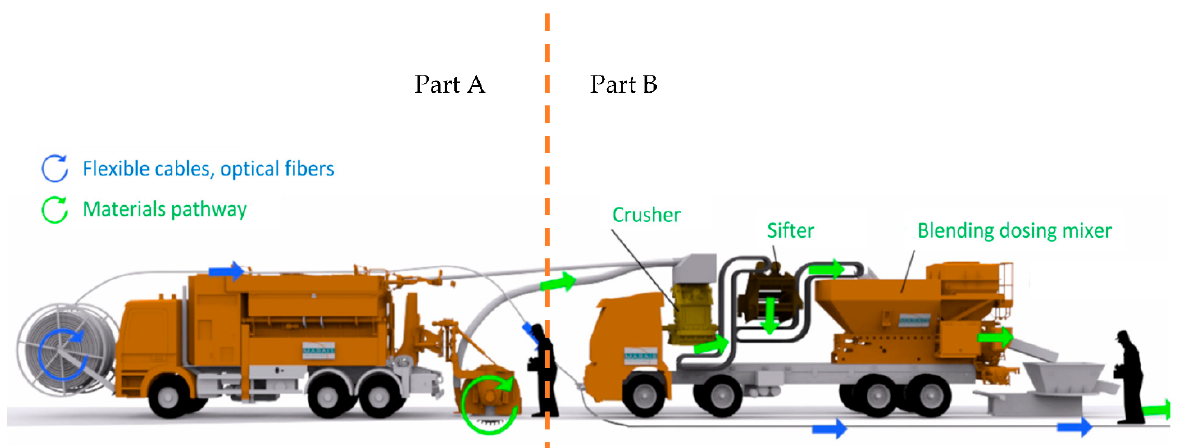
Figure 1. The combined mobile production unit for trenches ( part A ) and excavated material repro- cessing unit ( part B ).